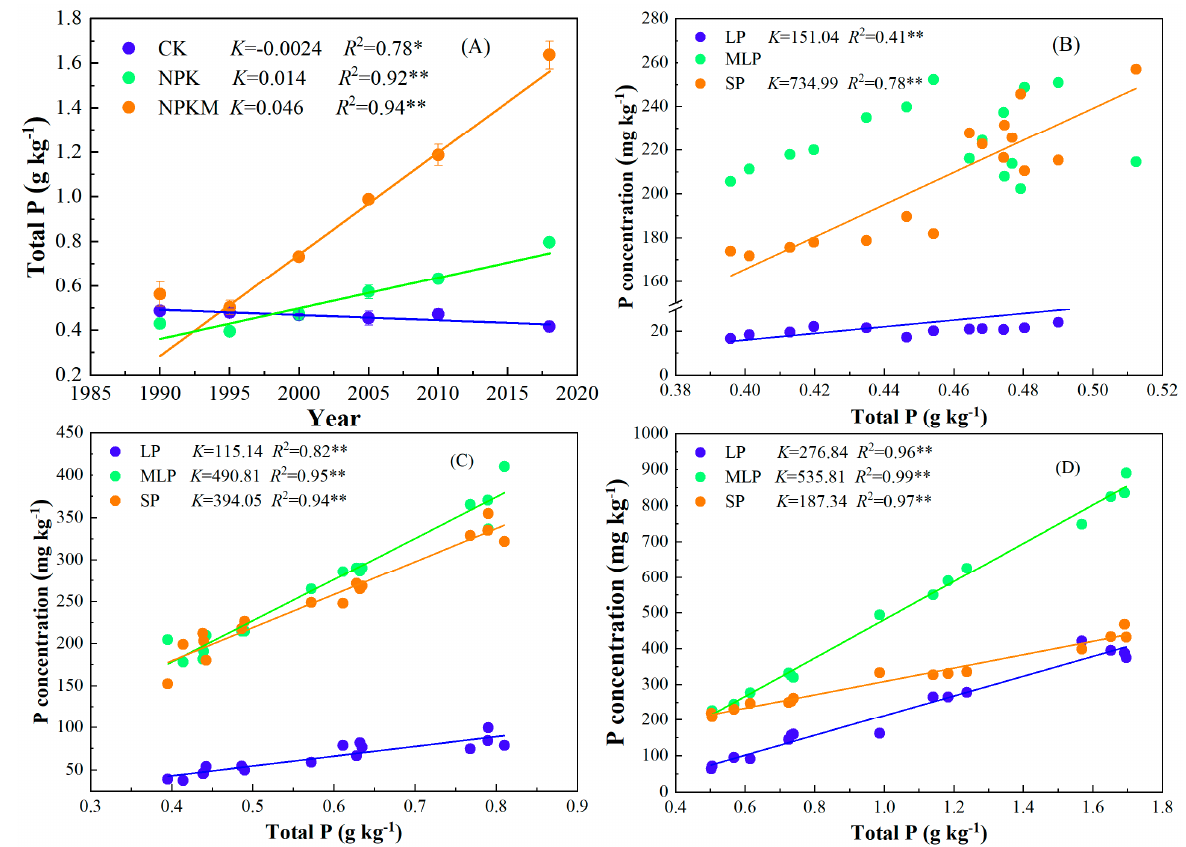
Figure 2. Total P content ( A ) and its relationship with P fraction in CK ( B ), NPK ( C ), and NPKM ( D ) treatments under long-term field trial in Mollisol. Fitted curves were: y = Kx + b. CK, no fertilizer input; NPK treatment, applying N, P, K fertilizer; NPKM treatment, applying NPK and manure (pig manure from 1990 to 2004, and cattle manure from 2005 to 2018). Total P, the sum content of each P fraction extracted by the Hedley sequential method. LP (labile P), the sum content of resin-P, NaHCO 3 -Pi, and NaHCO 3 -Po, MLP (Mid-labile P), the sum content of NaOH-Pi, NaOH-Po, and dil.HCl-Pi, SP (stable P), the sum content of conc.HCl-Pi, conc.HCl-Po and residual P. * and ** mean the relationship between total P and P fraction in p < 0.05, p < 0.01 level, respectively.